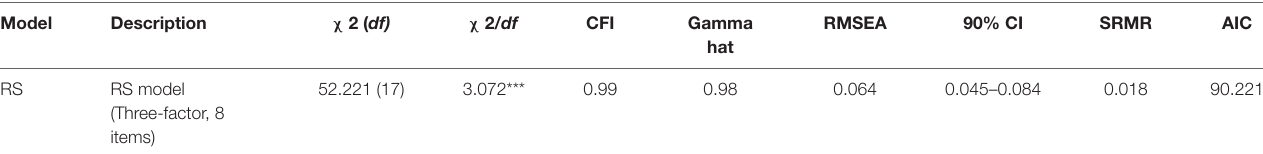
TABLE 7 | Model fit indices of research self-efficacy